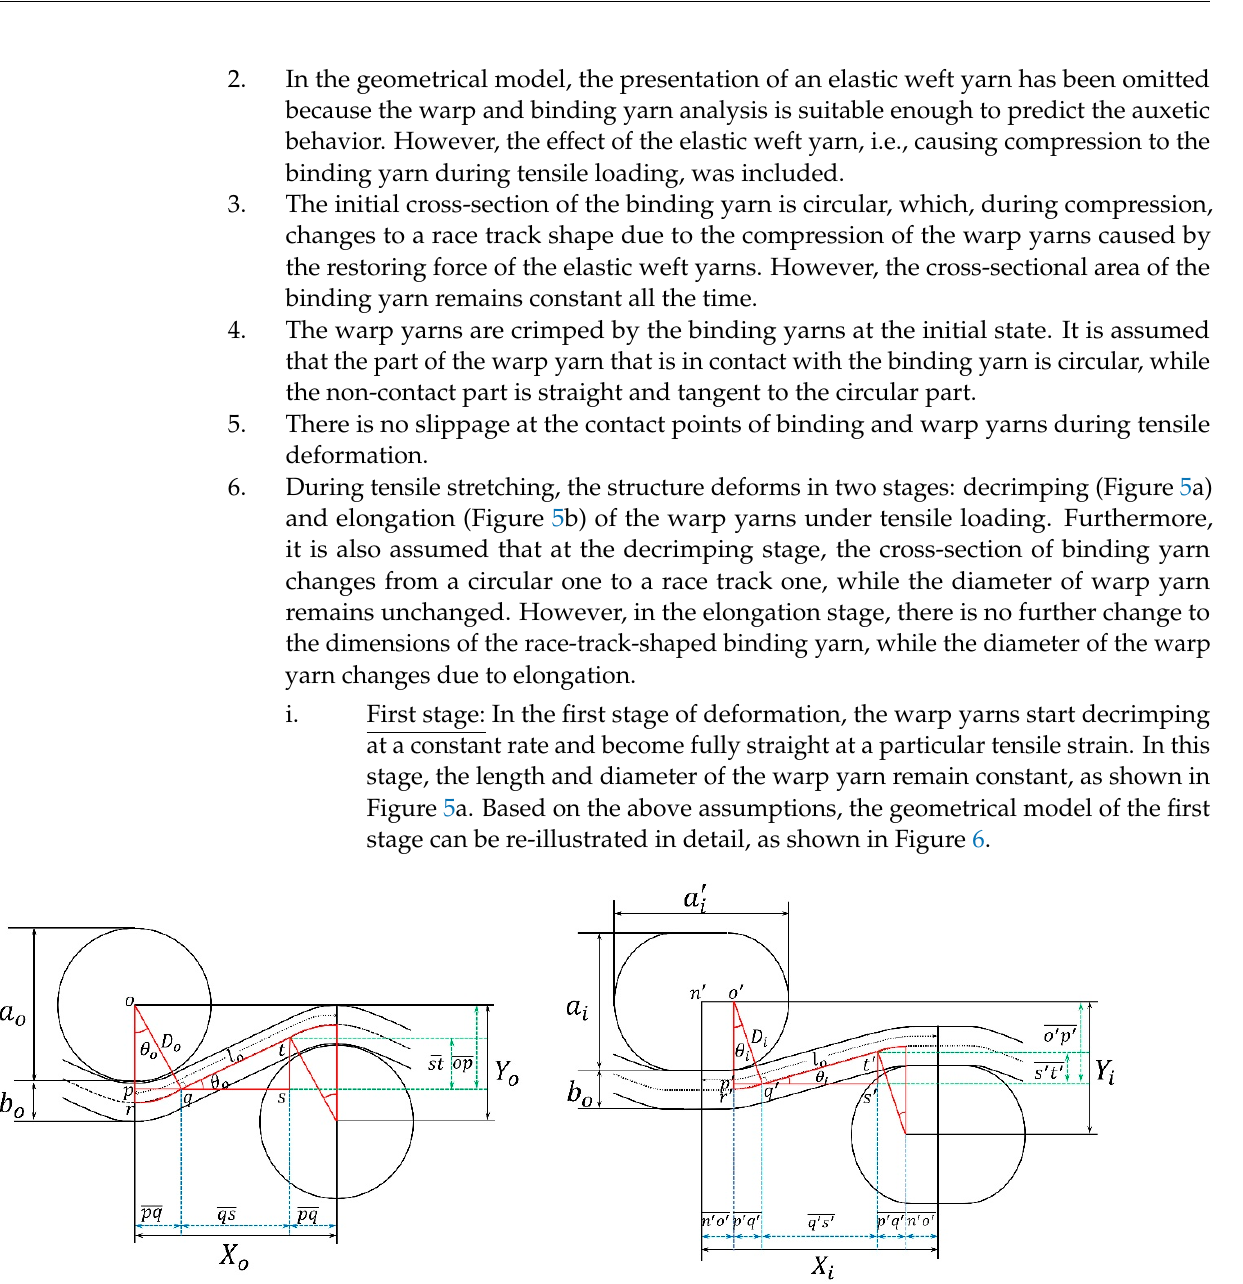
solving right angle triangles ∆ opq and ∆ qst ,